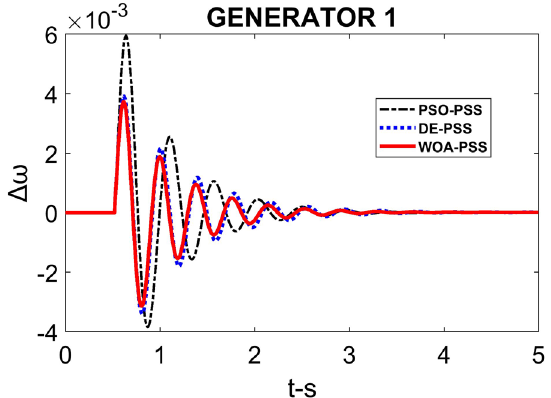
Fig. 7 Speed deviation of G1 for 10% step change at